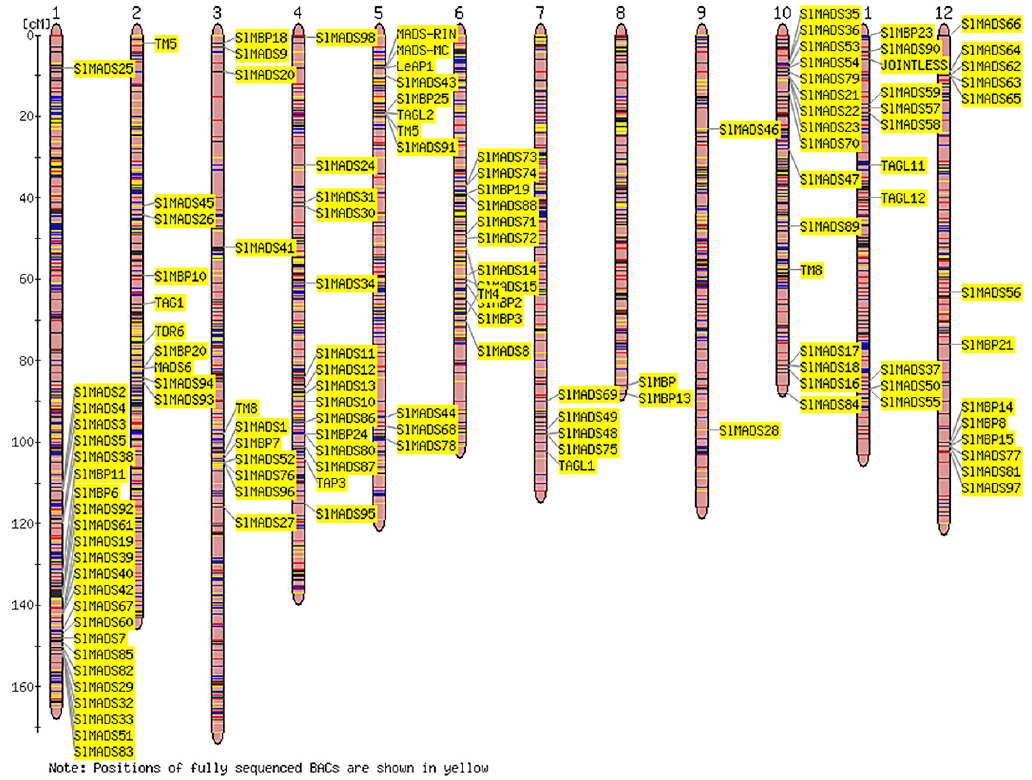
Figure 3. Chromosomal locations of tomato MADS-box genes. A total of 12 chromosomes of tomato were labeled with their names, chromosomes 1 to 12, which are indicated at the top of each bar. The position of tomato MADS-box genes on the chromosome was based on the Sol Genomics Network (SGN) and National Center for Biotechnology Information (NCBI) database and the Tomato-EXPEN 2000 was used to draw the physical map of the tomato MADS-box genes.